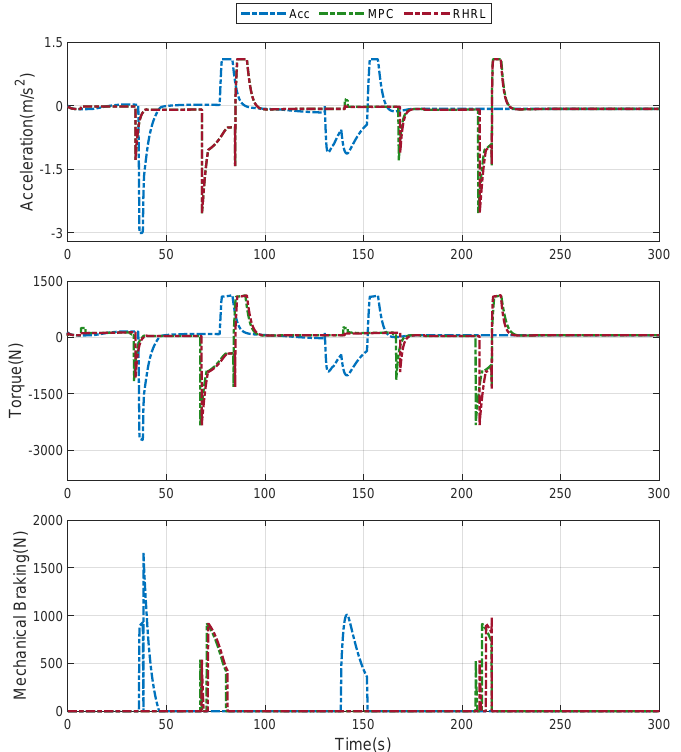
Figure 8. Comparison of the results obtained following the proposed velocity trajectory planning, rule-based ACC and MPC at the upper level. From top to bottom, the figures show the trajectories of acceleration demand, torque demand and mechanical brake